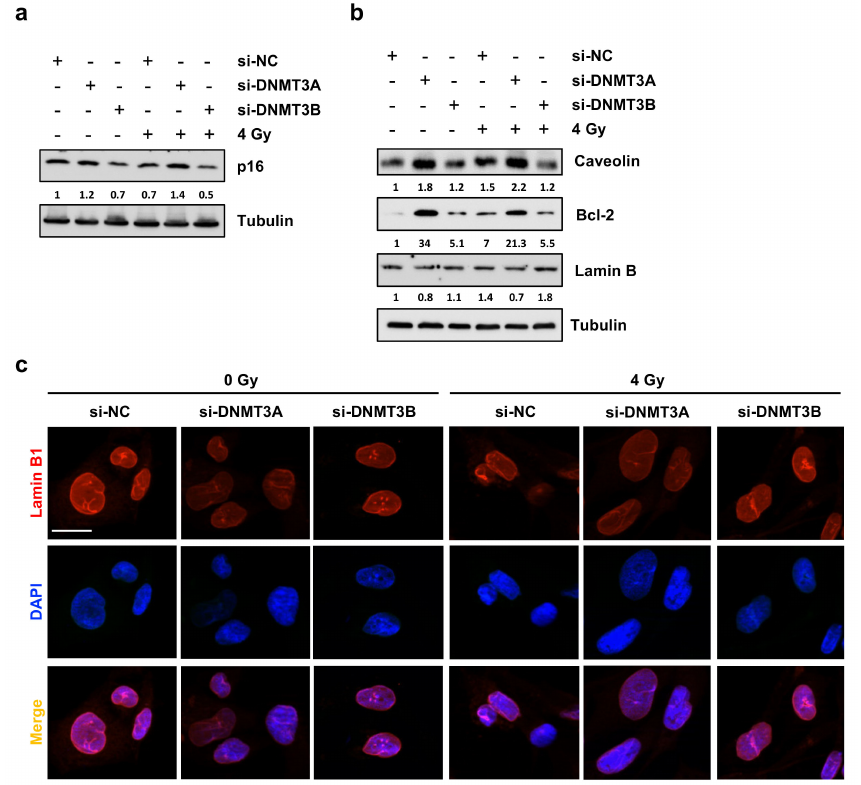
Figure 6. DNMT3A silencing radiosensitizes RD cells by triggering p16-related senescence program. ( a ) Western blotting showing p16 up-regulation in si-DNMT3A RD cells. Tubulin was used as loading control. ( b ) Western blotting assay of specific proteins modulated during the senescence process. Tubulin was used as internal control. ( c ) IF assays showing the expression of Lamin